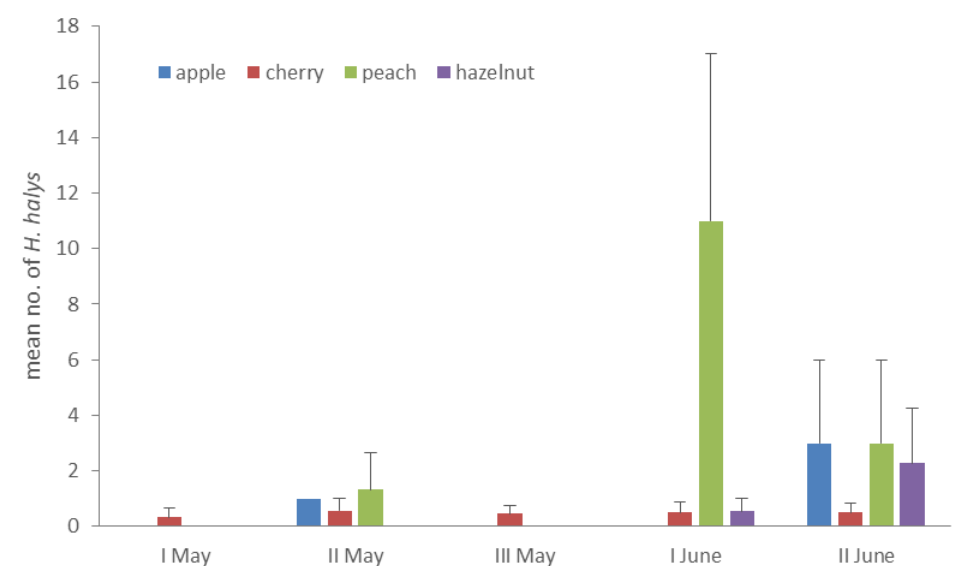
Figure 2. Mean numbers (±SE) of Halyomorpha halys adults per plant on the crops sampled from early May to mid-June.